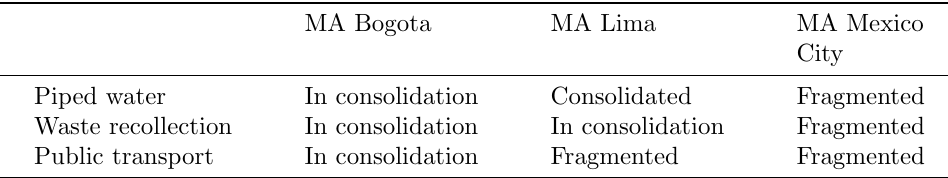
Table 1: Classification of service provision